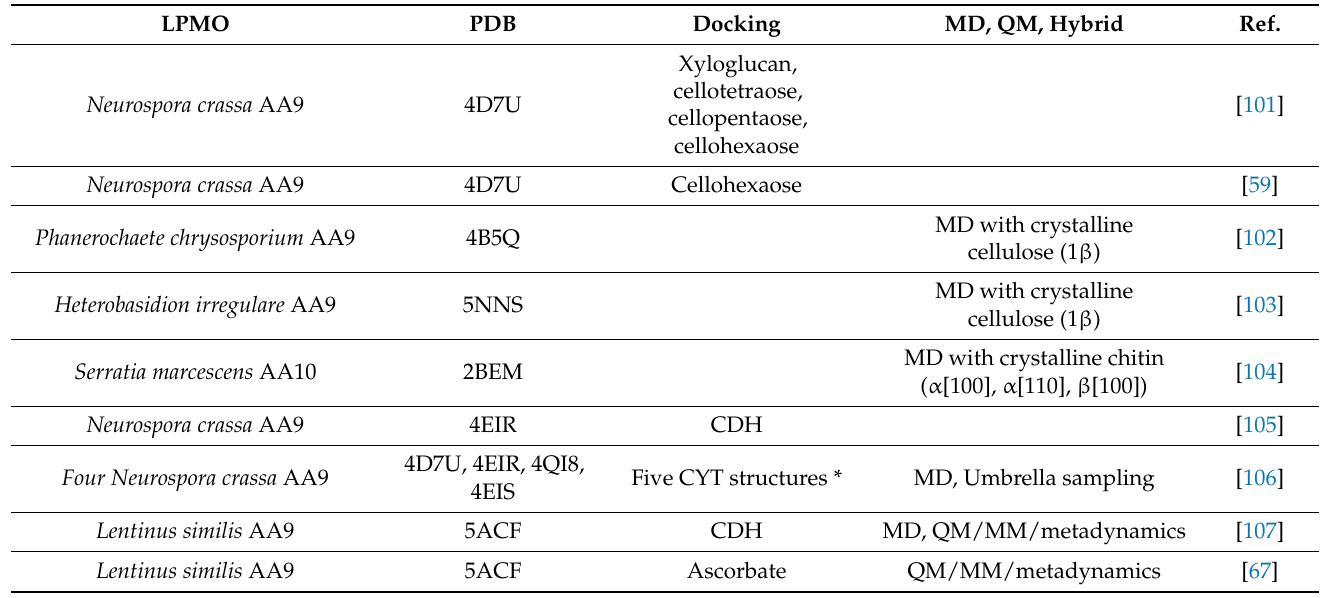
Figure 4. ( a ) Three-dimensional structure of three selected LPMOs in complex with oligosaccharide substrates, namely cellopentose (left, PDB 5NLS), xylopentaose (middle, PDB 5NLO), and gluco- mannose (right, PDB 5NKW). ( b ) Interaction energy analysis (kcal/mol) for PcAA9_D (left) and HiAA9_B (right). Calculated values have been mapped on the PDB 4B5Q and 5NNS, respectively. For HiAA9_B, only one of the two pinpointed orientations is shown, and energy values have been reported as the average over the different replicas in which the selected orientation has been obtained. Horizontal orange lines indicate the orientation of the polysaccharide chains laying on the enzyme’s flat surface. Table 1. Summary of the literature about molecular docking, MD, QM, or hybrid studies on LPMO interactions with substrates or reducing